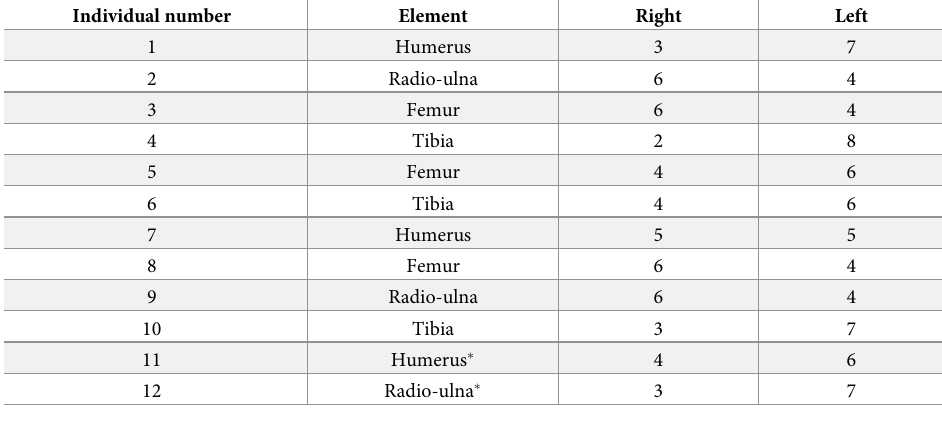
� These bones were